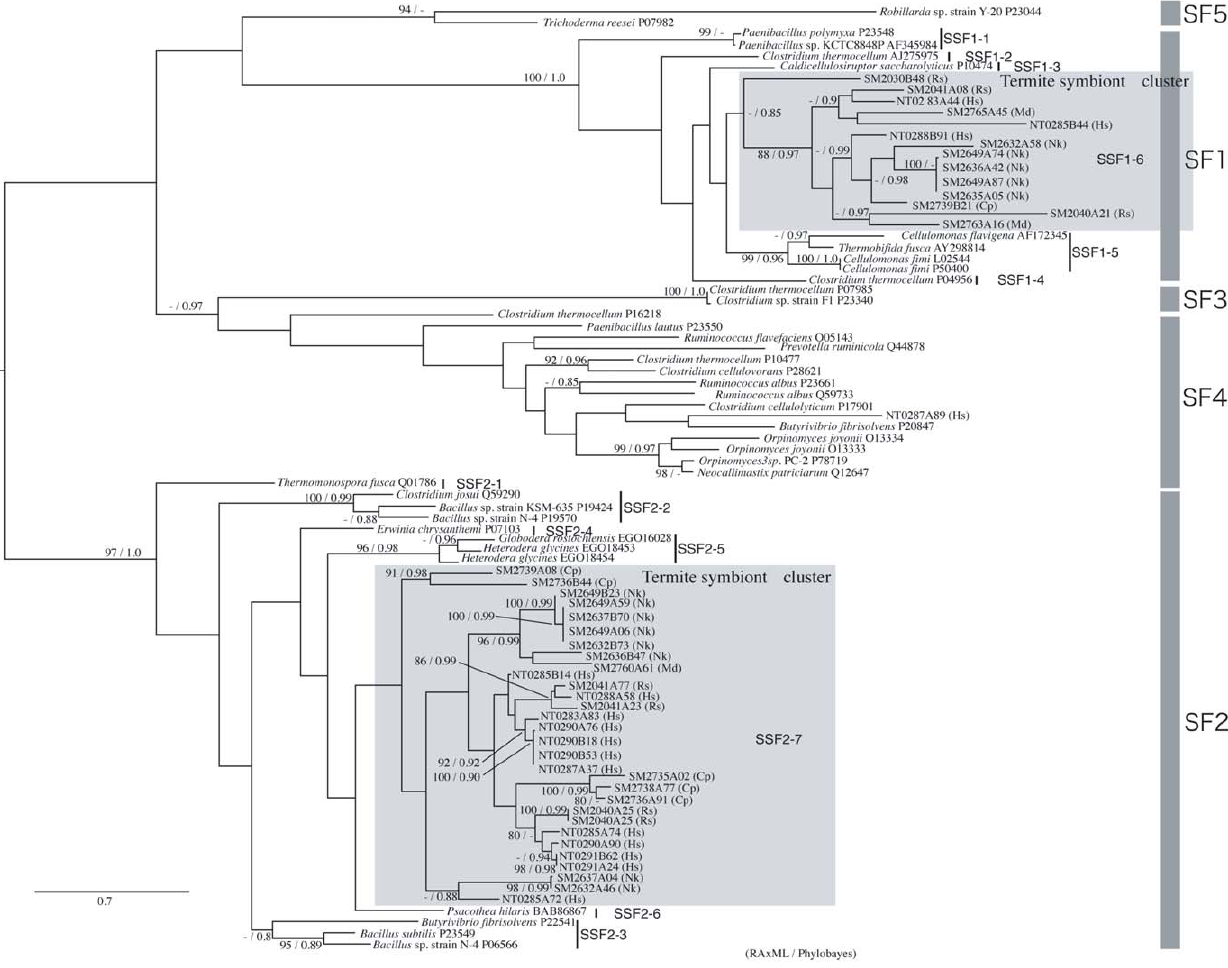
Figure. 2. Phylogenetic tree of GHF5. Numbered clones (for example SM2030B48) are cellulase genes identified in this study from the symbiotic protists of termites. Letters in parentheses after each clone denote host termite species (Rs = Reticulitermes speratus , Nk = Neotermes koshunensis , Hs = Hodotermopsis sjostedti , Md = Mastotermes darwiniensis , Cp = Cryptocercus punctulatus ). Accession numbers of reference sequences are denoted after species names. SF are indicated the sub-family (21) and SSFs are indicated sub-sub families that were used in Fig. 3. In sub-family 1 and 2, gray boxed sub-sub-family indicated that composed by symbiont’s sequences and other sub-sub-families composed by bacterial sequences.